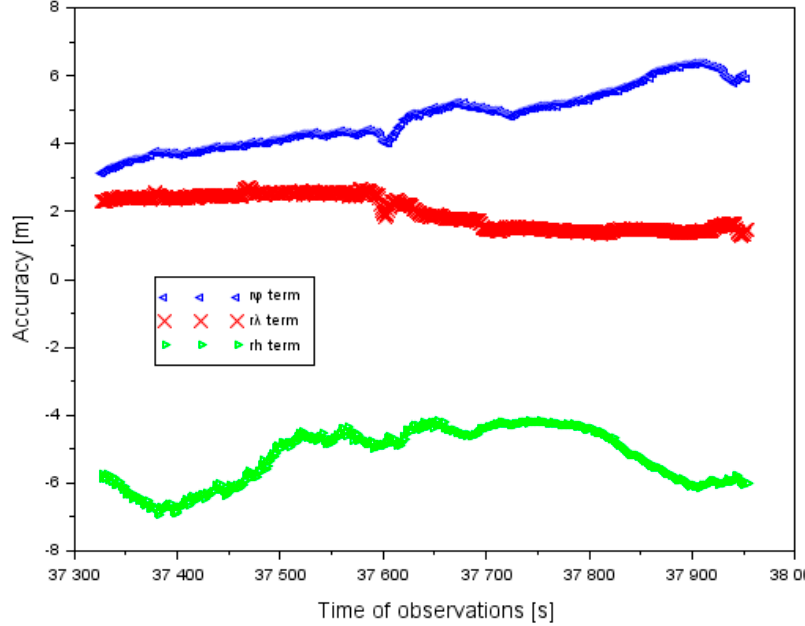
Figure 11. The accuracy of aircraft positioning based on GPS data and without EGNOS (European Geostationary Navigation Overlay Service) correction in ellipsoidal coordinates in the air test in D ę blin.